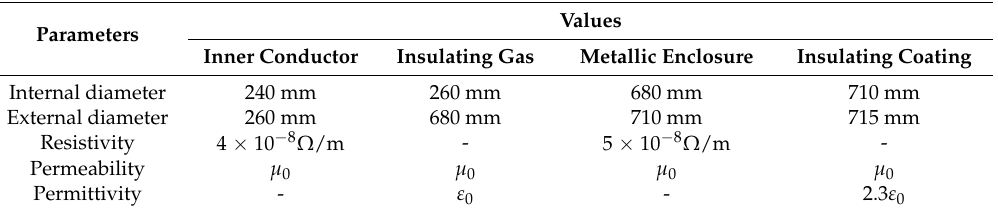
Table 2. Parameters of a 1000 kV GIL.